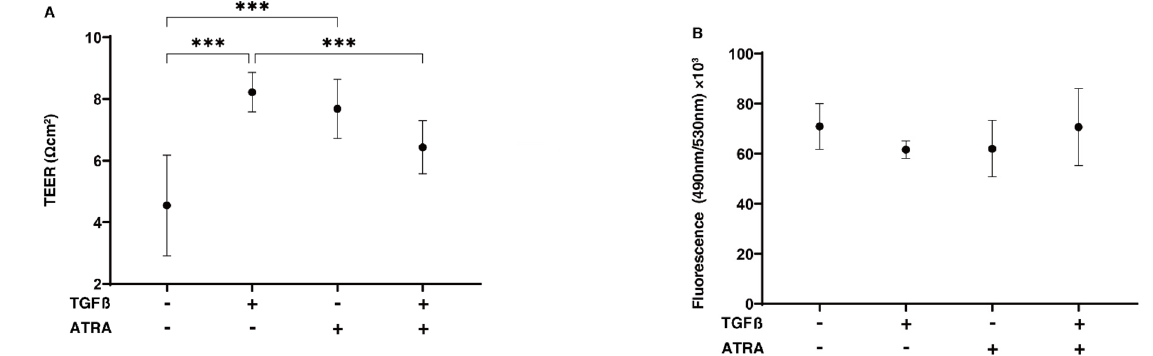
phorylation to glycolysis, ATRA alone did not affect cellular metabolism in the 2D-cultured HTM cells.